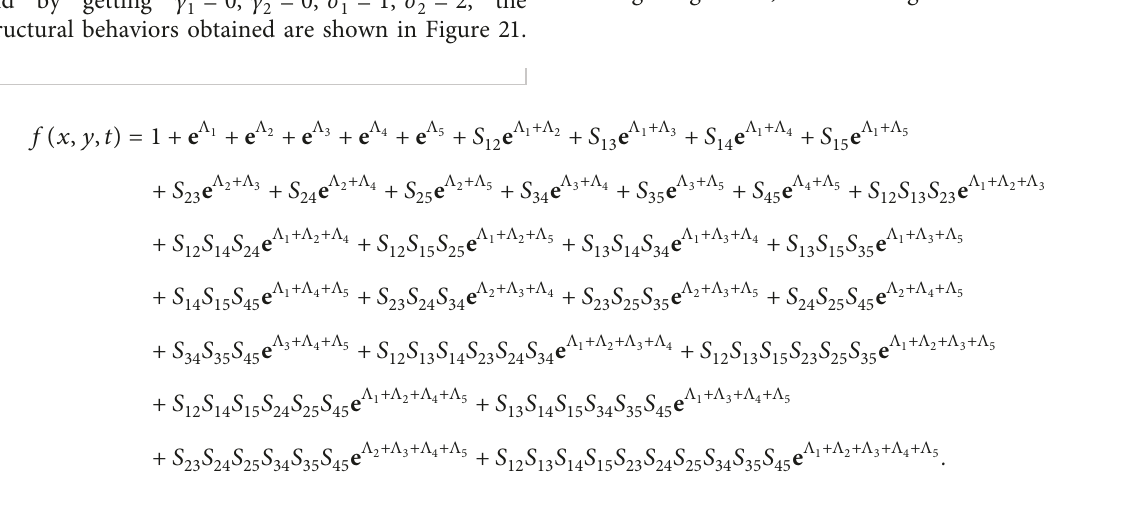
� 1 , c � 1/10. (a), (d) t � − 100. (b), (e) t � 0. (c), (f) t � 0 1